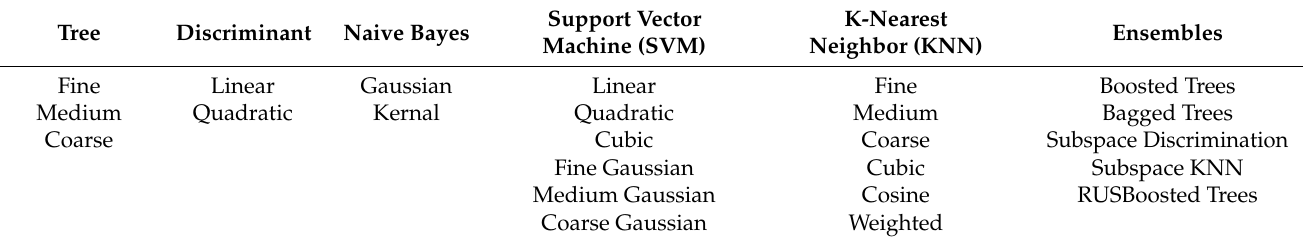
Table 1. List of the 24 algorithms tested as classification methods in this paper. These algorithms are the most classical ones used in supervised machine learning for multinomial classification included in the Classification Learner app found in the Statistics and Machine Learning